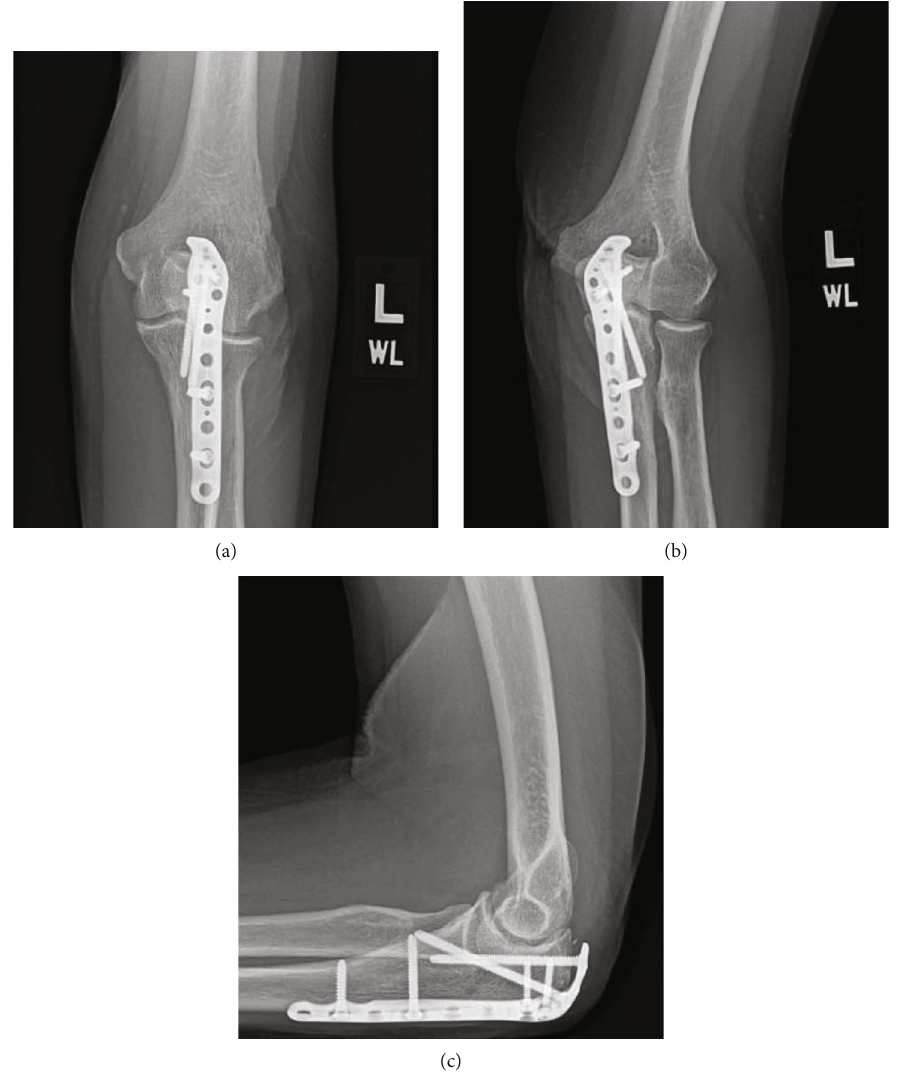
Figure 2: AP (a), oblique (b), and lateral (c) radiographs of the patient ’ s left olecranon at the 3-month follow-up visit after operative fi